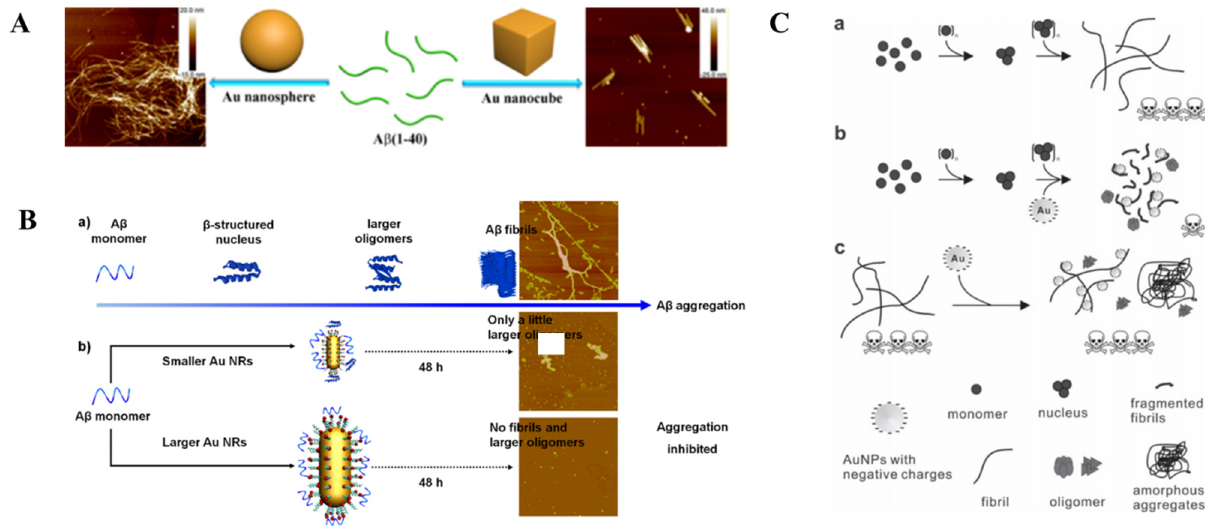
Figure 1. ( A ) Schematic of effects of gold nanospheres and nanocubes on A β 1–40 peptide fibrillation. Reprinted with permission from reference [43]. Copyright 2019 American Chemical Society. ( B ) Schematic of (a) the process of A β aggregation and (b) The schematic of CTAB-stabilized AuNRs with different sizes inhibiting A β peptides fibrillation [44]. Copyright 2019 Elsevier. ( C ) Diagram of A β fibrillization pathways influenced by negatively charged AuNPs. (a) A β monomers assemble into mature amyloid fibrils and cause neurotoxicity. (b) A β monomers incubated with the AuNPs possessing negative surface potential lead to formation of short and fragmented fi brils along with spherical oligomers. The alteration rescues the toxicity generated from mature A β fibrils. (c) AuNPs addition to preformed A β fibrils induces ragged fi brils and amorphous aggregates without changing the toxicity level[41]. Copyright 2012 Wiley-VCH.